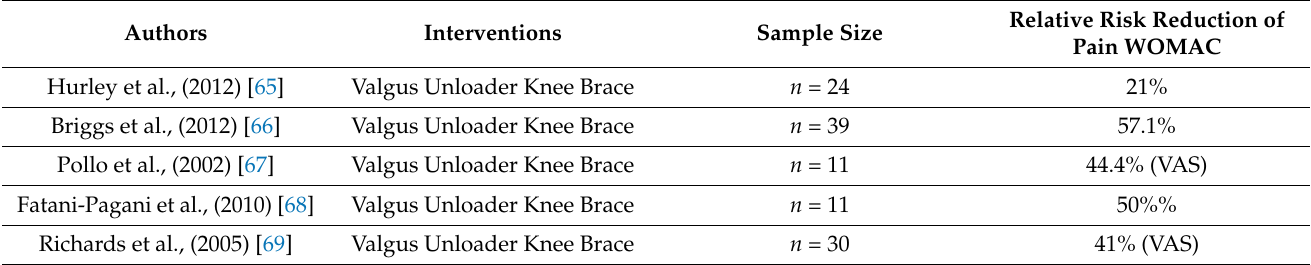
Table 4. Summary of the findings from the five papers with interventions regarding knee